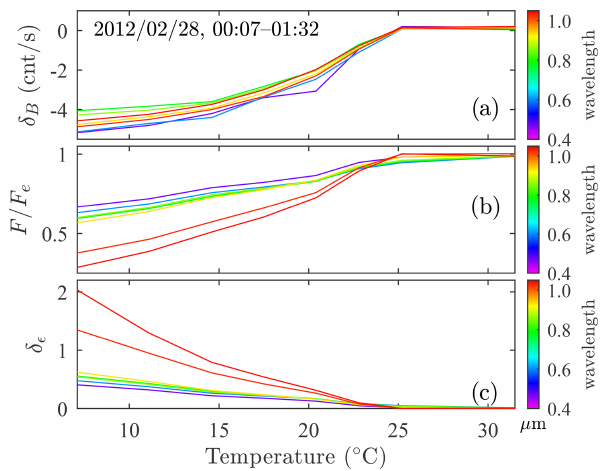
Figure 24. B variation ( δ B ) due to dark-current decrease when the instrument enclosure temperature starts below the control range (a) . Detector sensitivity as a function of temperature (b) and the corre- sponding observation error δ (cid:15) = xδ τ (cid:39) | F − F e | /F (c) . The mea- surements shown in this figure were acquired with the SPST09/C11 at Eureka.